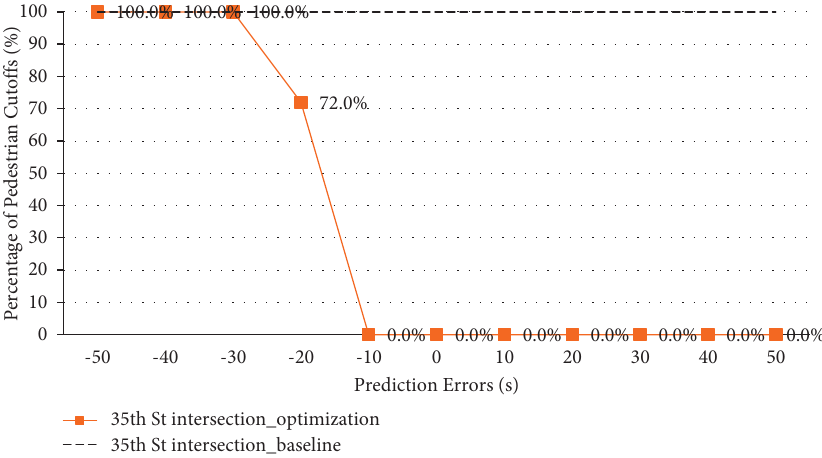
Figure 10: Percentages of pedestrian phase cutoffs in relation to prediction errors at 35th Street intersection.